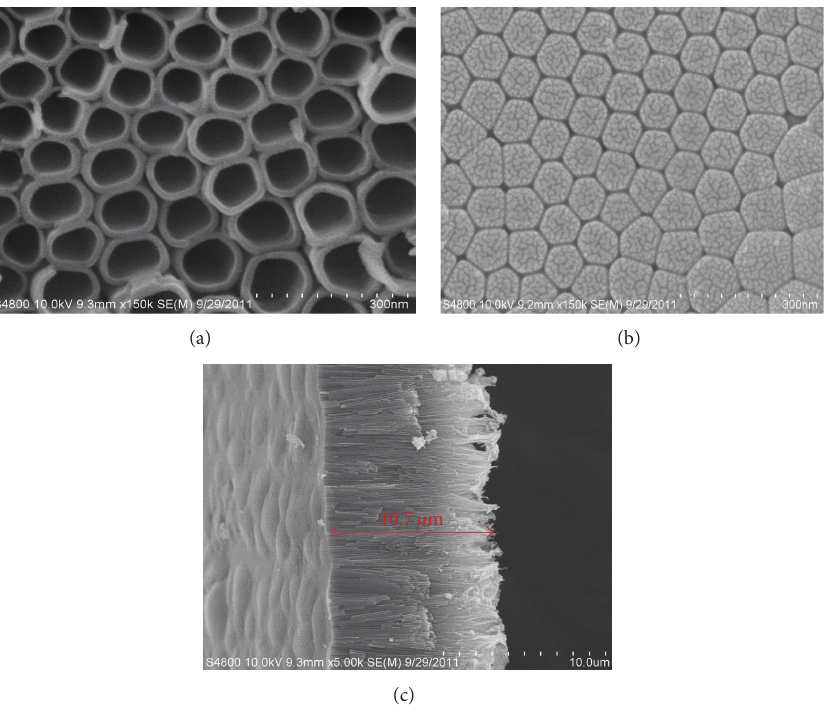
Figure 3: SEM images of TNT-arrays in top-view (a), in bottom-view (b), and in cross-sectional-view (c).